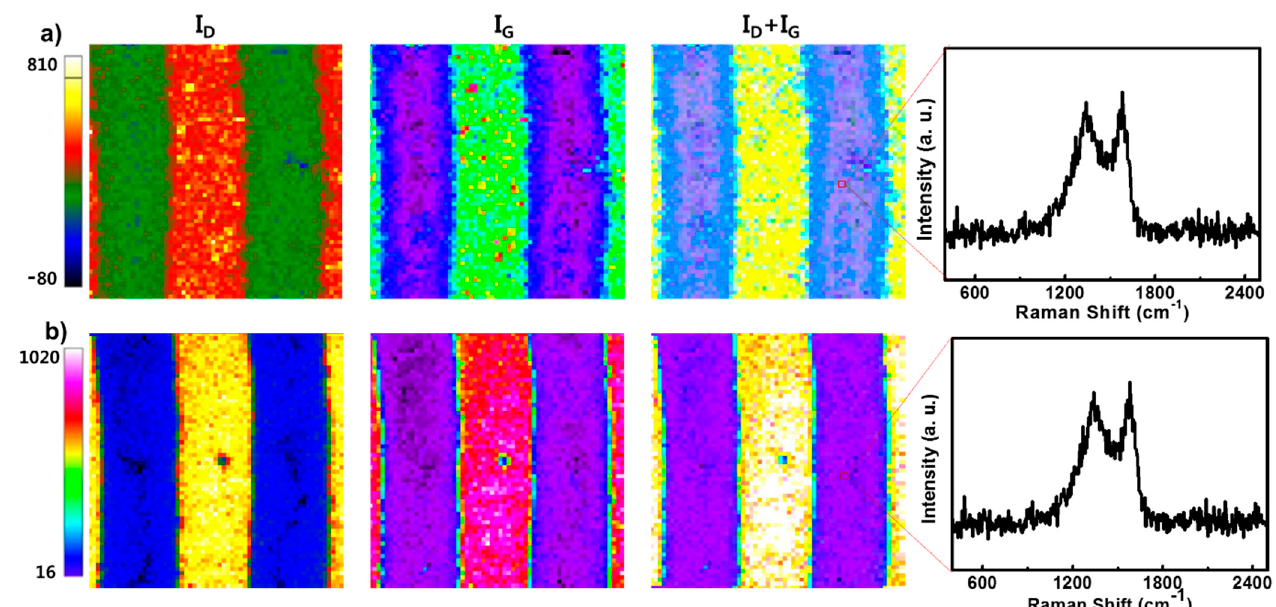
Figure 4. Raman mapping of ( a ) energy density is 36 J/cm 2 , ( b ) energy density is 42 J/cm 2 (300 × 300 μ m 2 ).